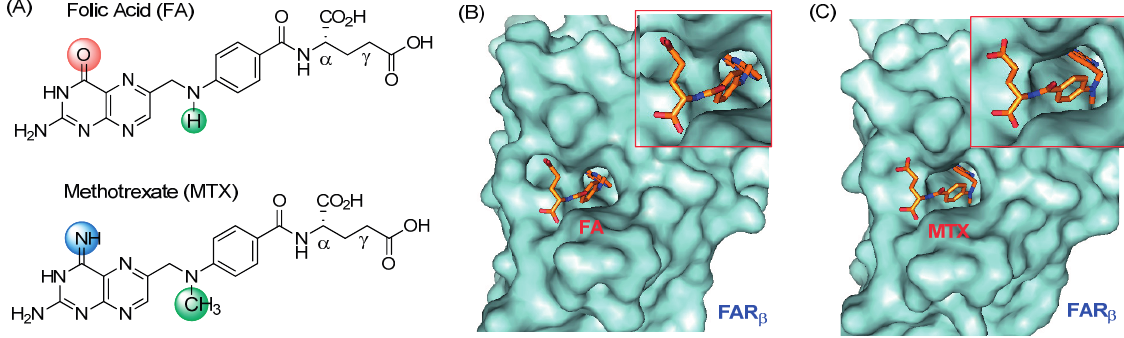
Figure 2. ( A ) Structures of folic acid (FA) and methotrexate (MTX); ( B , C ) The crystal structure of human folate receptor beta (FOLR2) bound with FA or MTX at its ligand site (PDB code 4KNO) [67]. Inset: an expanded view of each bound ligand molecule. Surface images of the receptor-ligand complexes were generated by PyMOL™ (version